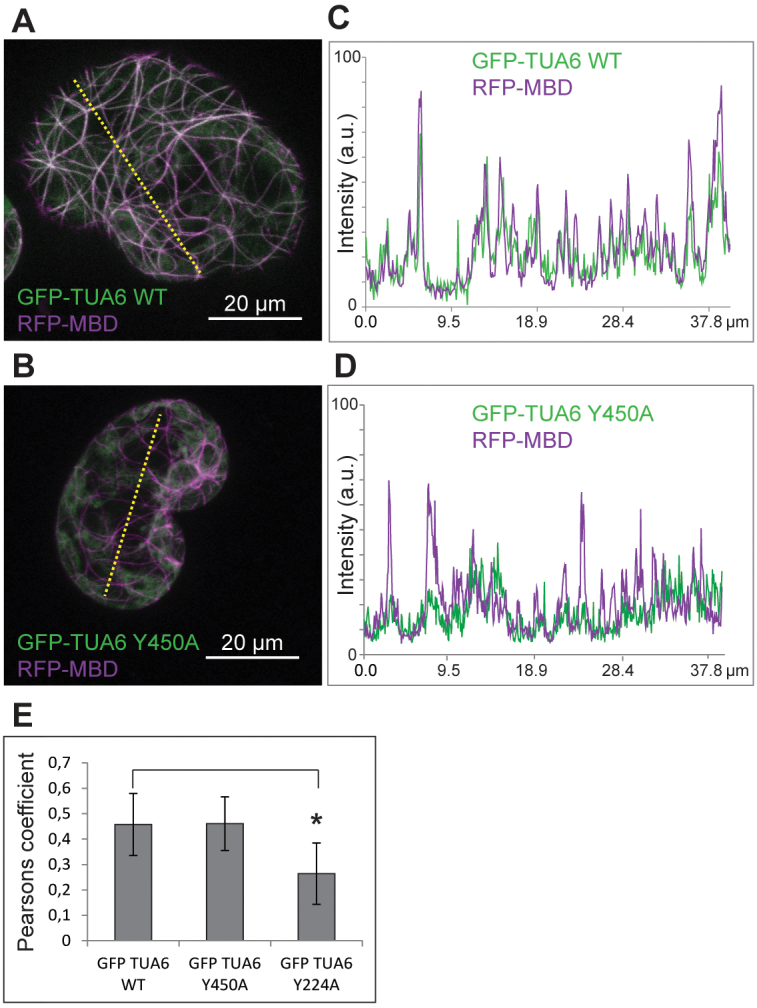

Arabidopsis thaliana protoplasts co-expressing TUA6 p35S:GFP-TUA6 (green) and p35S:RFP-MBD (magenta). (A) Protoplast co-expressing p35S:GFP-TUA6 WT and p35S: RFP-MBD. (C) Plot profile of fluorescent signal intensities along the dotted line in (A). (B) Protoplasts co-expressing p35S:GFP-TUA6 Y450A and p35S: RFP-MBD. (D) Plot profile of fluorescent signal intensities along the dotted line in (B). (E) Mean Pearsons correlation coefficient determined for GFP and RFP in protoplasts co-expressing p35S:RFP-MBD together with either p35:GFP-TUA6 WT (0.45±0.12, n=14) or mutant p35:GFP-TUA6 Y450A (0.46±0.10, n=14) and p35:GFP-TUA6 Y224A (0.26±0.12, n=14, *P>0.001).